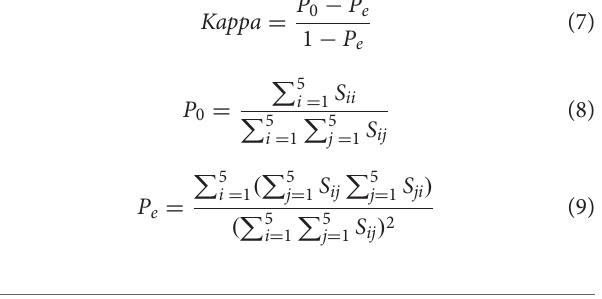
TABLE 1 | The distribution of samples in data